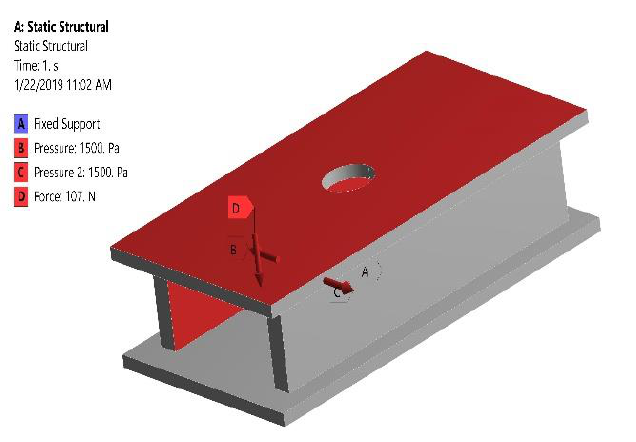
Figure 7. Hull model with boundary conditions